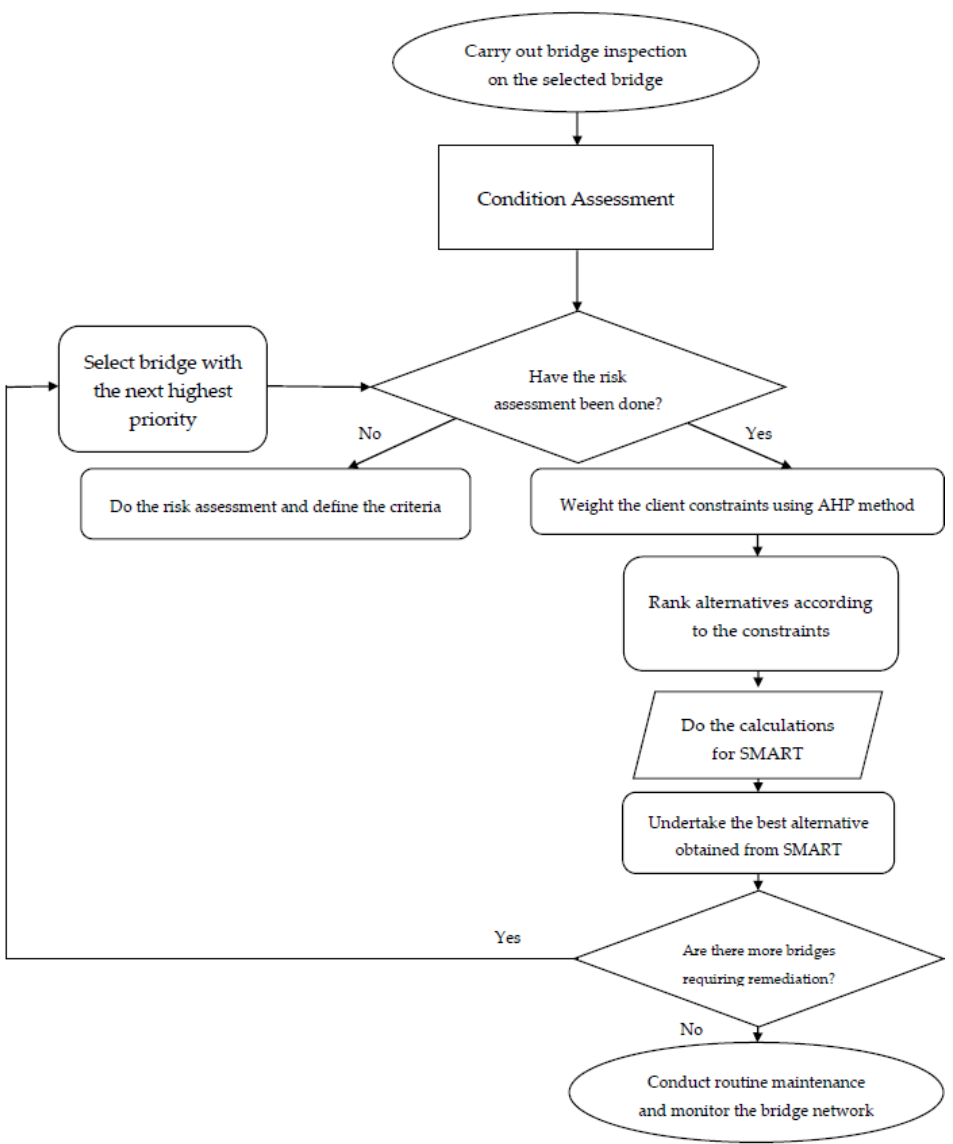
Figure 4. Flow Chart of the Proposed Method for Strategy Selection at Project Level.